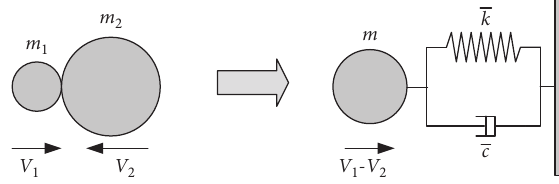
Figure 1: Improved Kelvin analytical model.